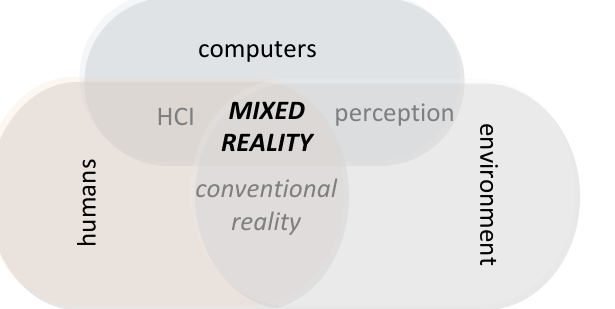
Figure 3. Microsoft’s approach for MR, as a result of the interactions between computers, humans, Figure 3. Microsoft's approach for MR, as a result of the interactions between computers, humans, and environments. Adapted from [8]. and environments. Adapted from [8].